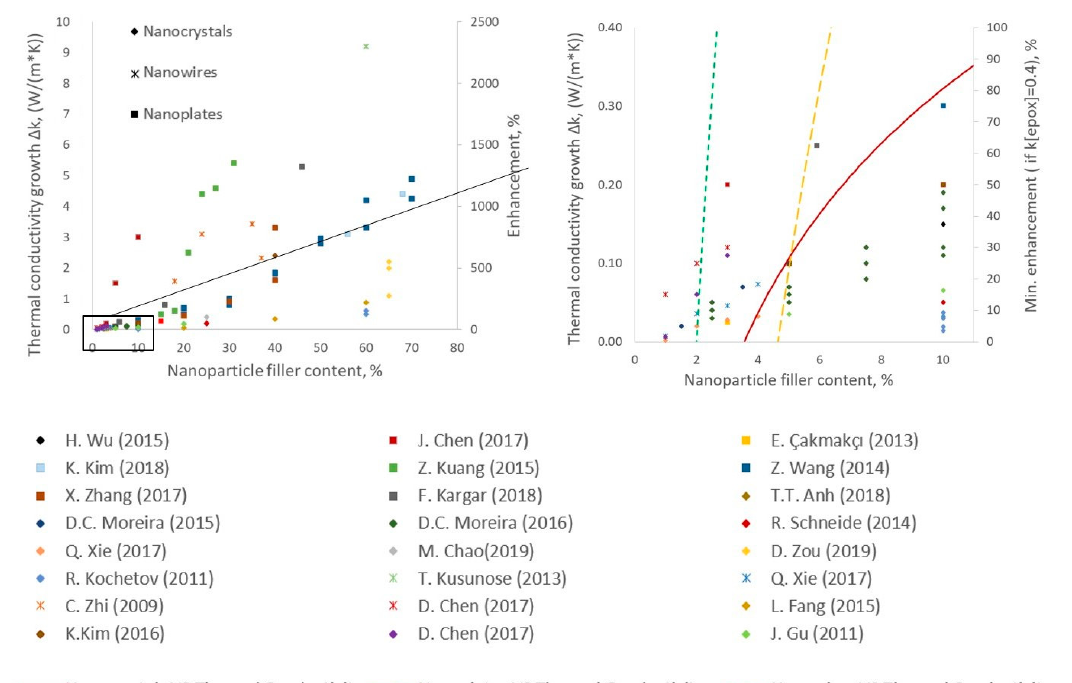
Figure 11. Thermal conductivity properties of dielectric nanoparticles [50,78,81–100], full-scale comparison and close-up. Three trends compare in fl uence of 0D, 2D, and 1D particles.